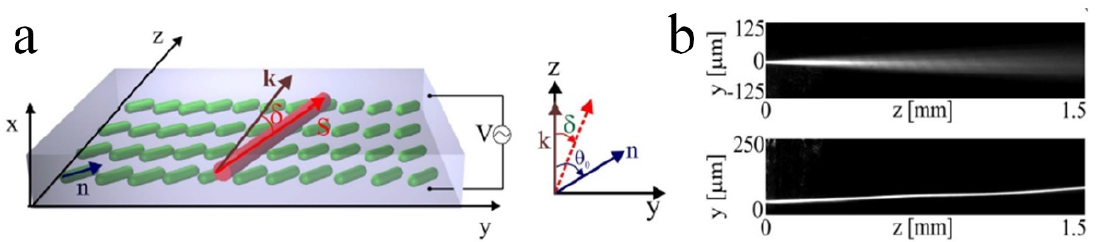
Figure 5. ( a ) Schematic of the formation of a nematicon in a planar nematic LC cell. ( b ) Photographs of a propagating ordinary light beam (top) and a nematicon (bottom). Reprinted with permission from Ref. [34]. Copyright 2019 Optical Society of America.